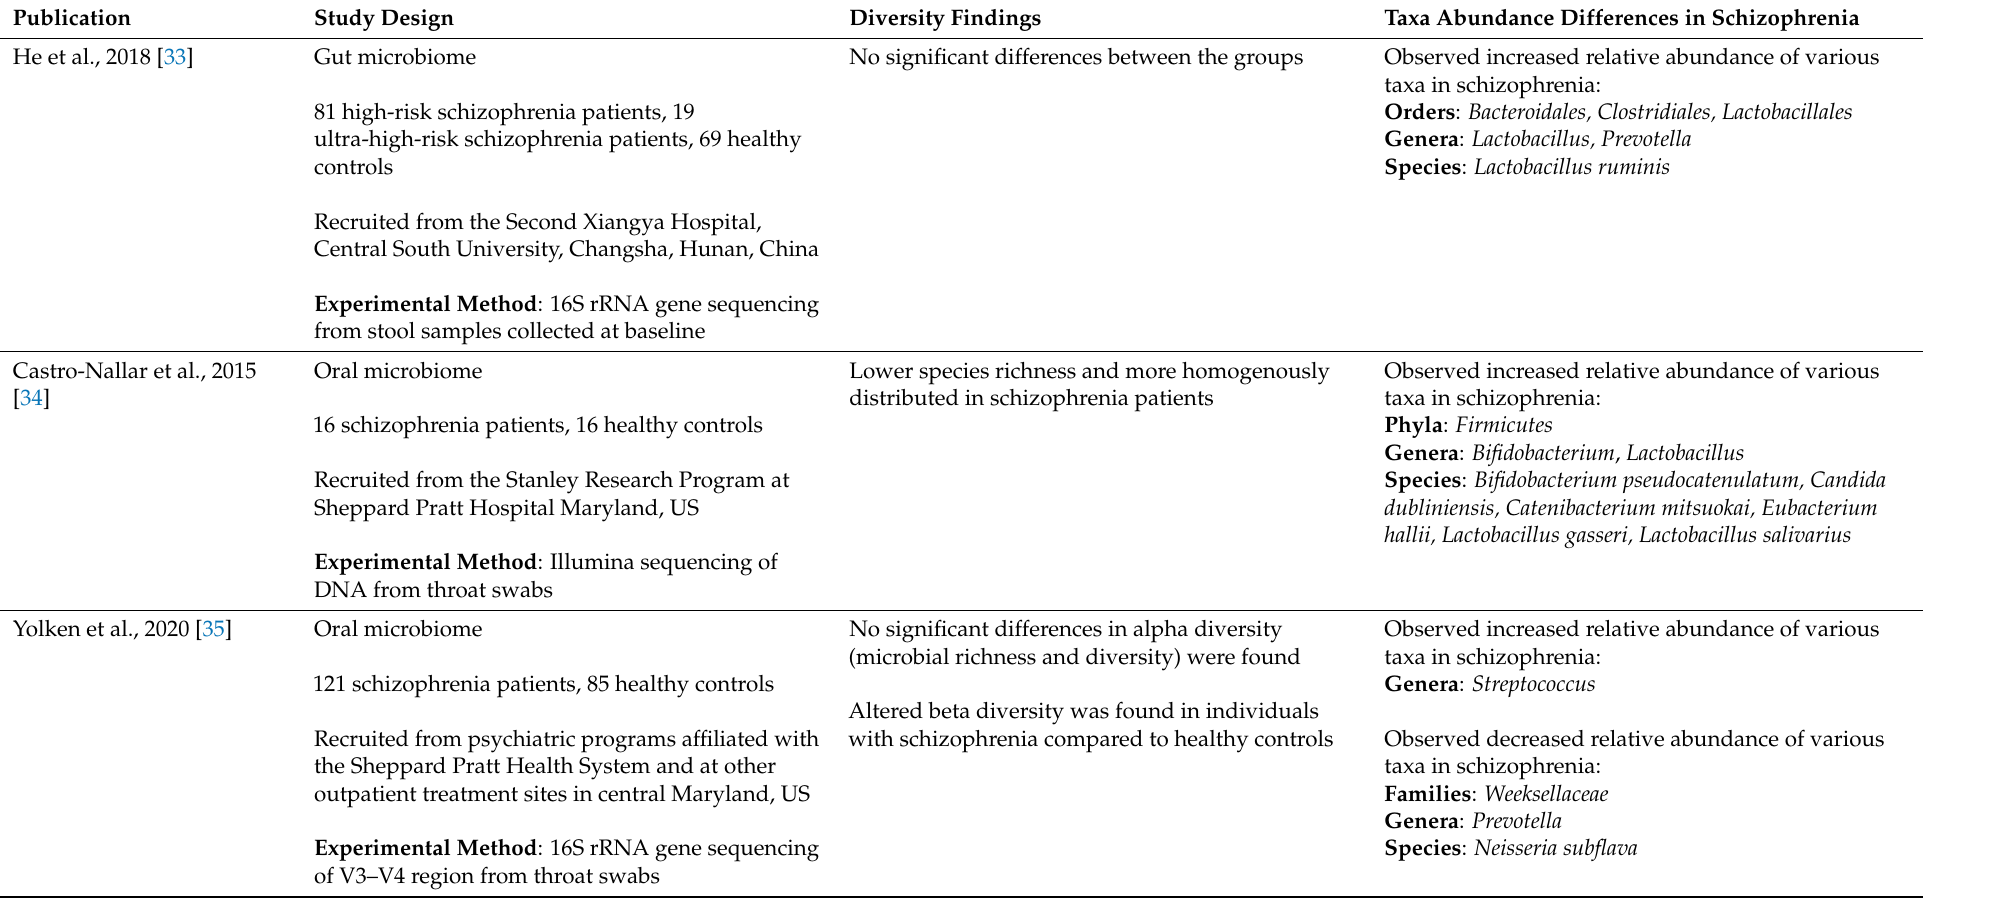
Table 1. Summary of studies investigating the microbiome in patients with